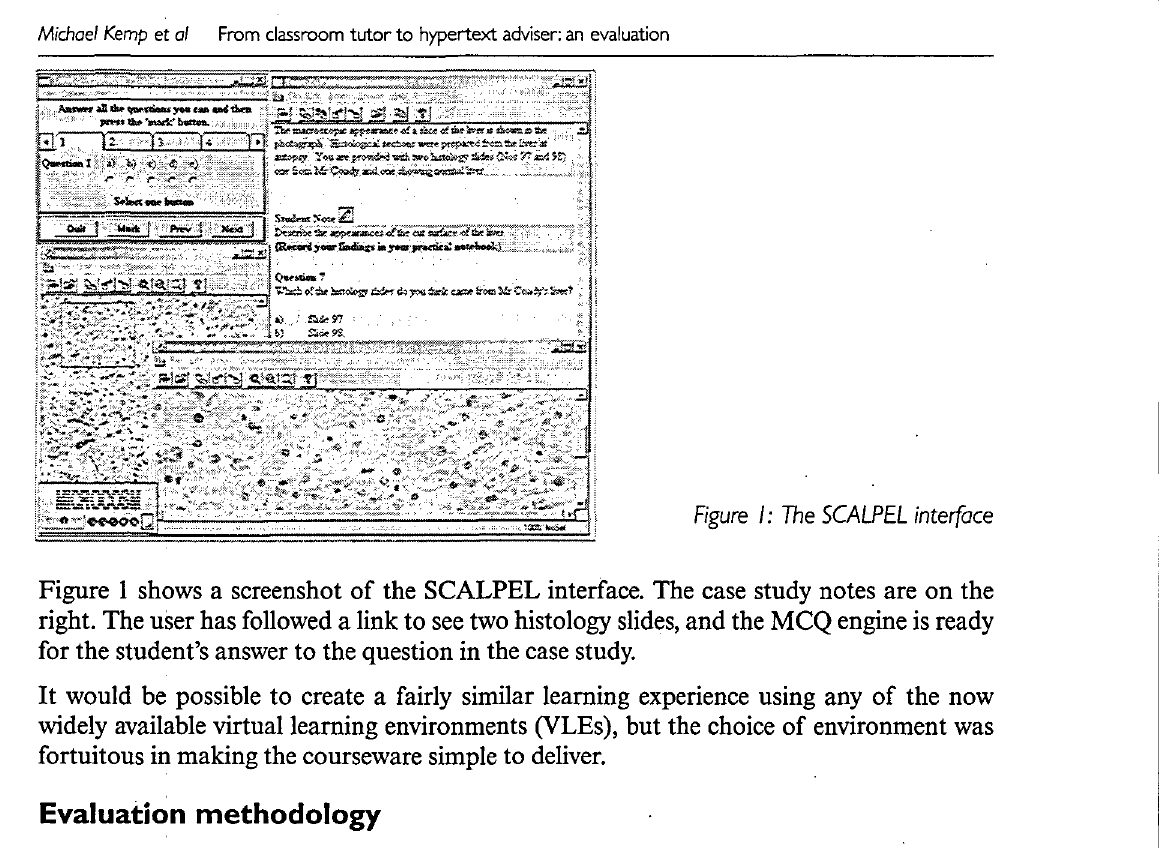
figure /: 7he SCALPEL